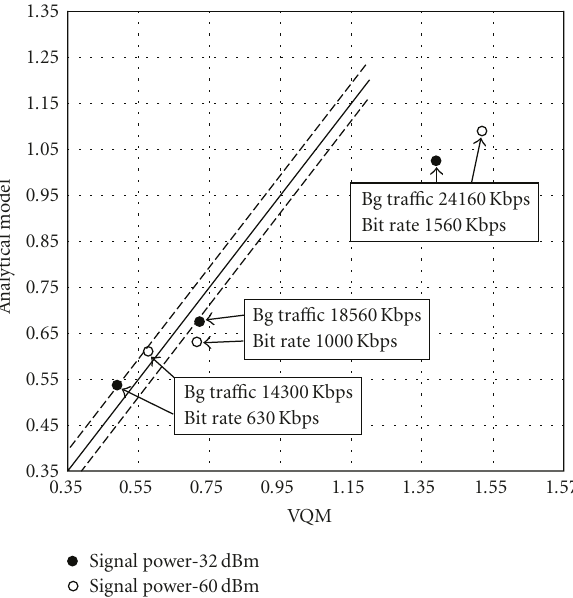
Figure 10: VQM quality versus analytical model quality, signal power levels − 32 dBm and − 60